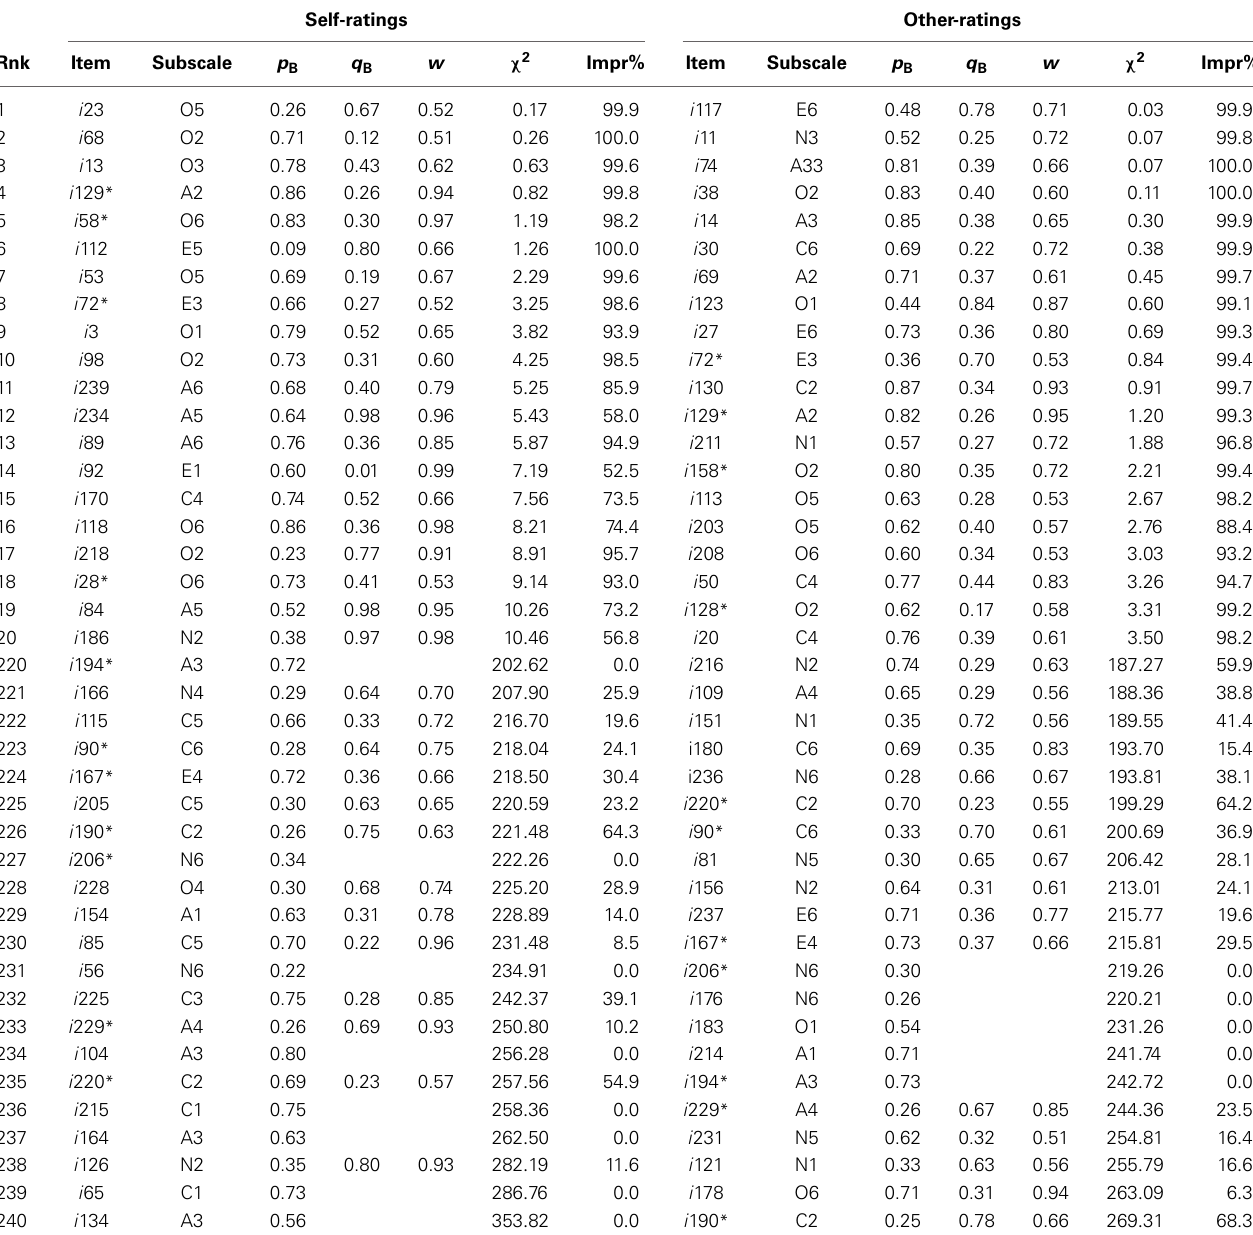
Table 1 | Twenty best and worst NEO PI3 self- and other-rated items in terms of the χ 2 -statistic for a mixed-binomial approximation. Self-ratings